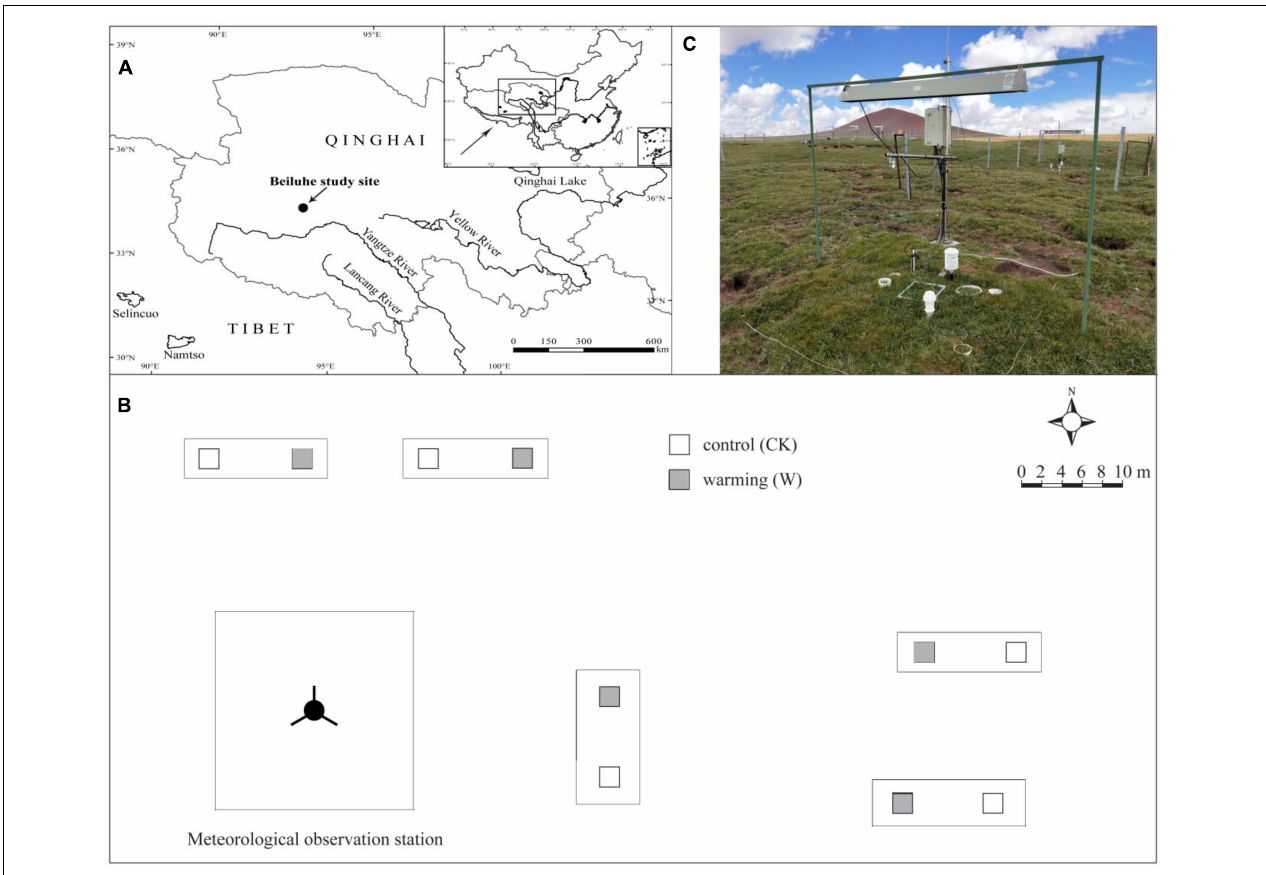
FIGURE 1 | The research site on the Qinghai-Tibetan Plateau; (A) map of the site at the Beiluhe Station of Permafrost Engineering and Environment; (B) the experimental design with control and warming treatments; (C) photograph of a warmed plot with instrumentation in an alpine meadow.